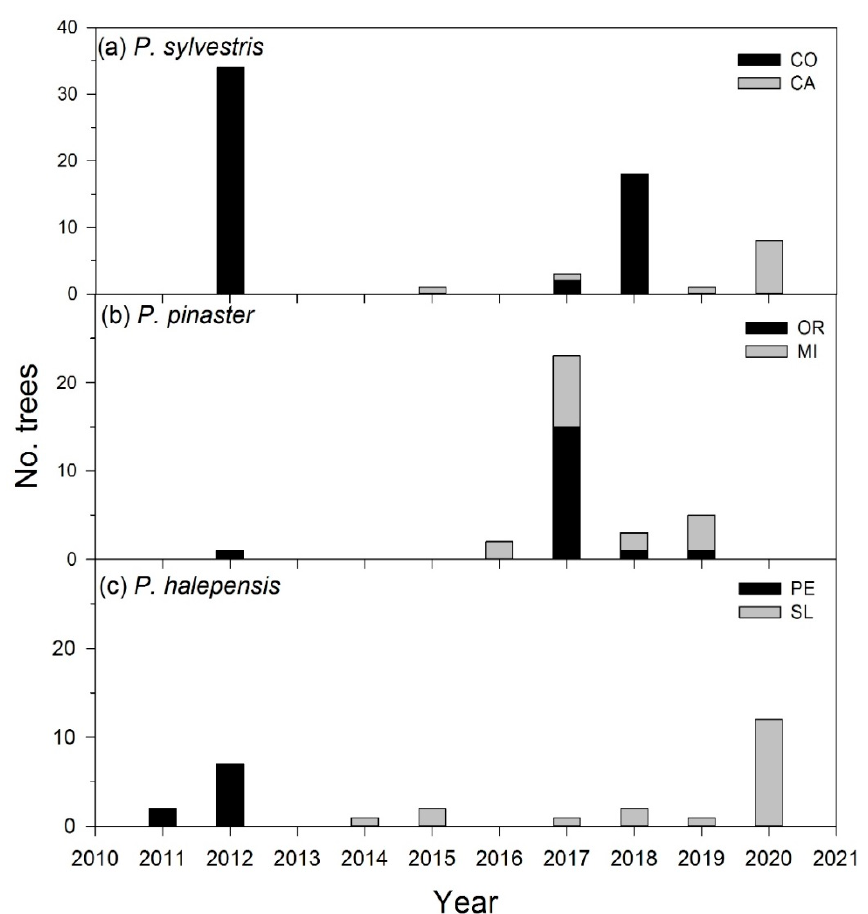
Figure 2. Frequency of recent tree deaths observed in the three study species ( a – c ) and considering two sites per species (see Table 1). Sites’ codes are in Table 1. Table 3. Growth data and related statistics. Values are means ± SD. The rbar is the mean of correlations among all radii, and the EPS is the Expressed Population Signal. Different letters indicate significant ( p < 0.05) differences in mean basal area increment or tree-ring width between living (ND) and dead (D) trees according to Student’s t-tests.